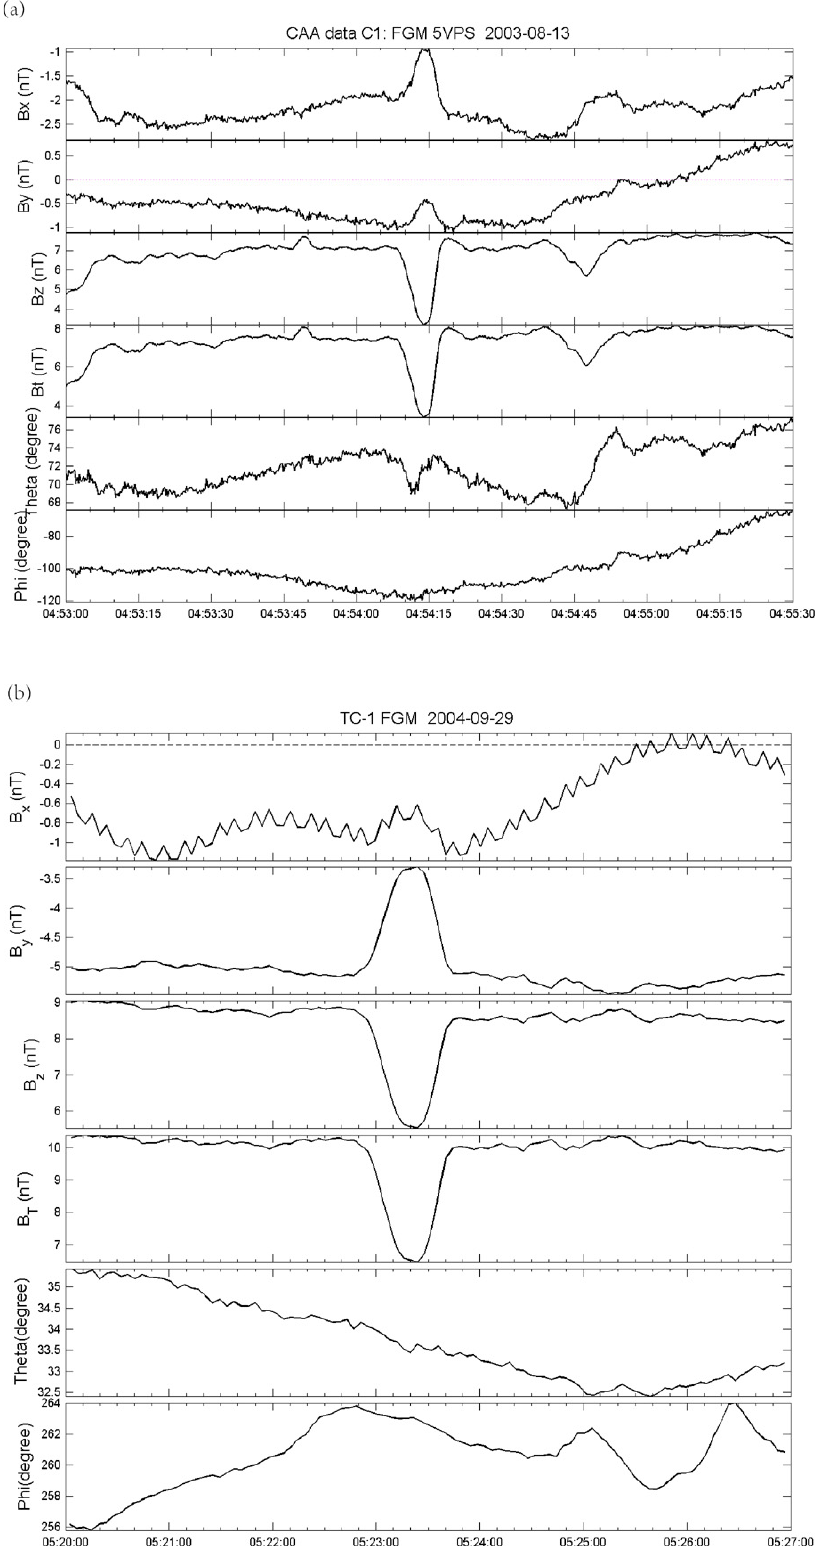
Fig. 1. (a) A magnetic hole observed by Cluster. (b) A magnetic hole observed by TC-1. From top to bottom panels: the GSM X component of magnetic field; Y component; Z component; the magnetic field magnitude; the polar angle; the azimuthal